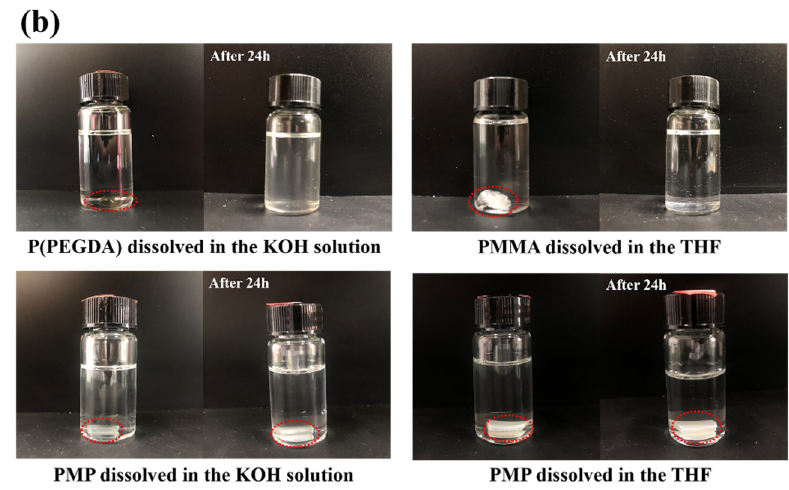
Figure 2. ( a ) FTIR spectra and ( b) dissolution performance in different solvents for samples of PMMA, P(PEGDA) and PMP. The samples are indicated by red circles.